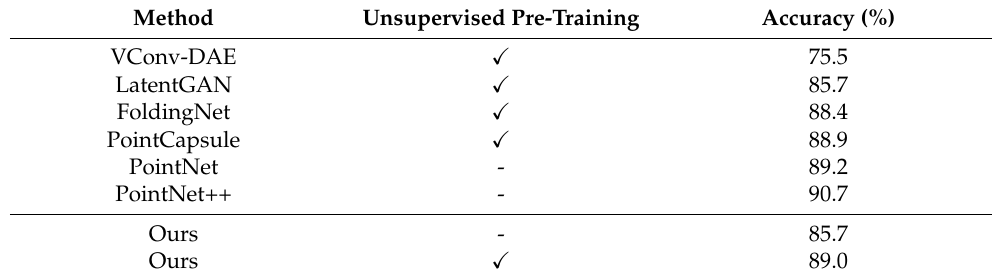
Table 1. ModelNet40 classification accuracy.